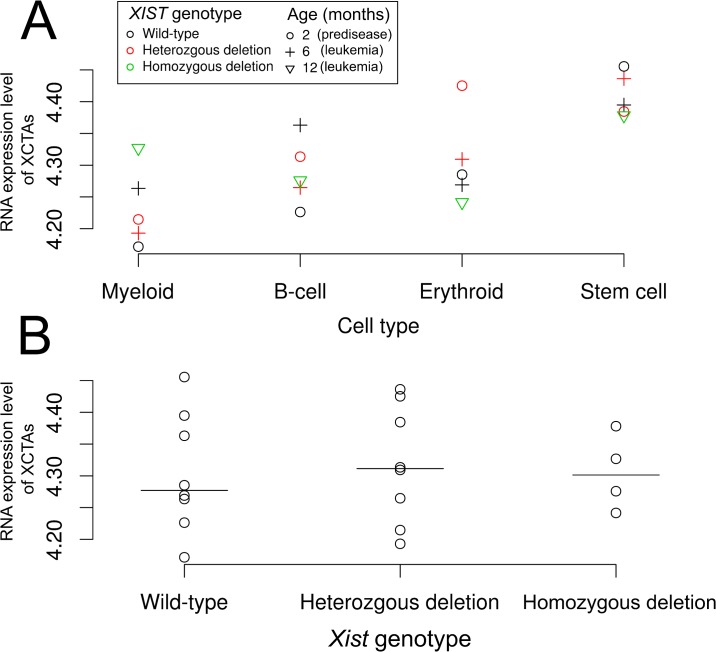
RNA expression of cancer-testis antigens located on the X chromosome of Xist knockout mice.The points represent mean RNA expression of 16 cancer-testis antigens located on the X chromosome among blood cell types (A) and Xist genotypes (B). Bars represent medians (B).